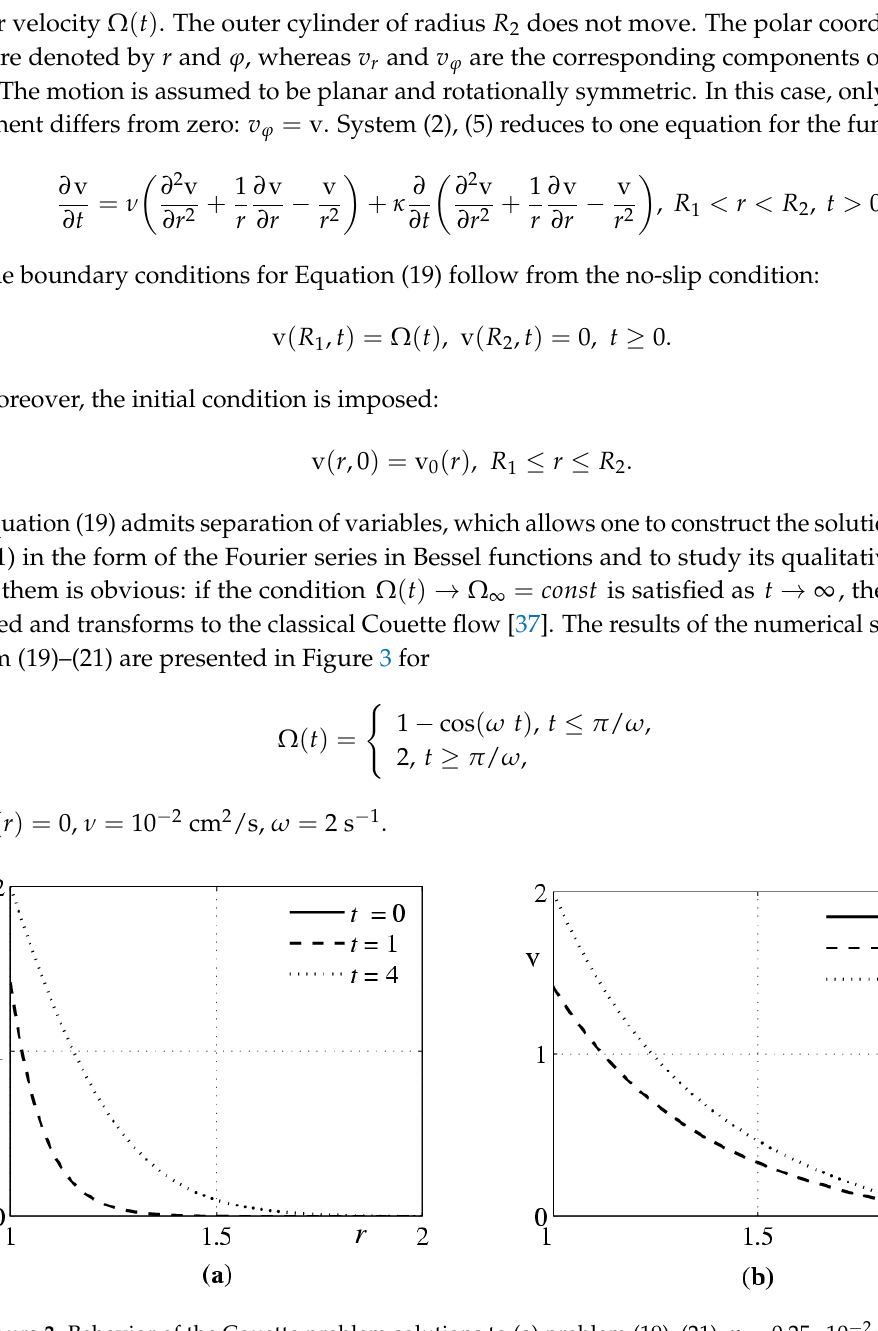
Figure 3. Behavior of the Couette problem solutions to ( a ) problem (19)–(21), κ = 0.25 · 10 − 2 ; ( b ) usual fluid, κ =